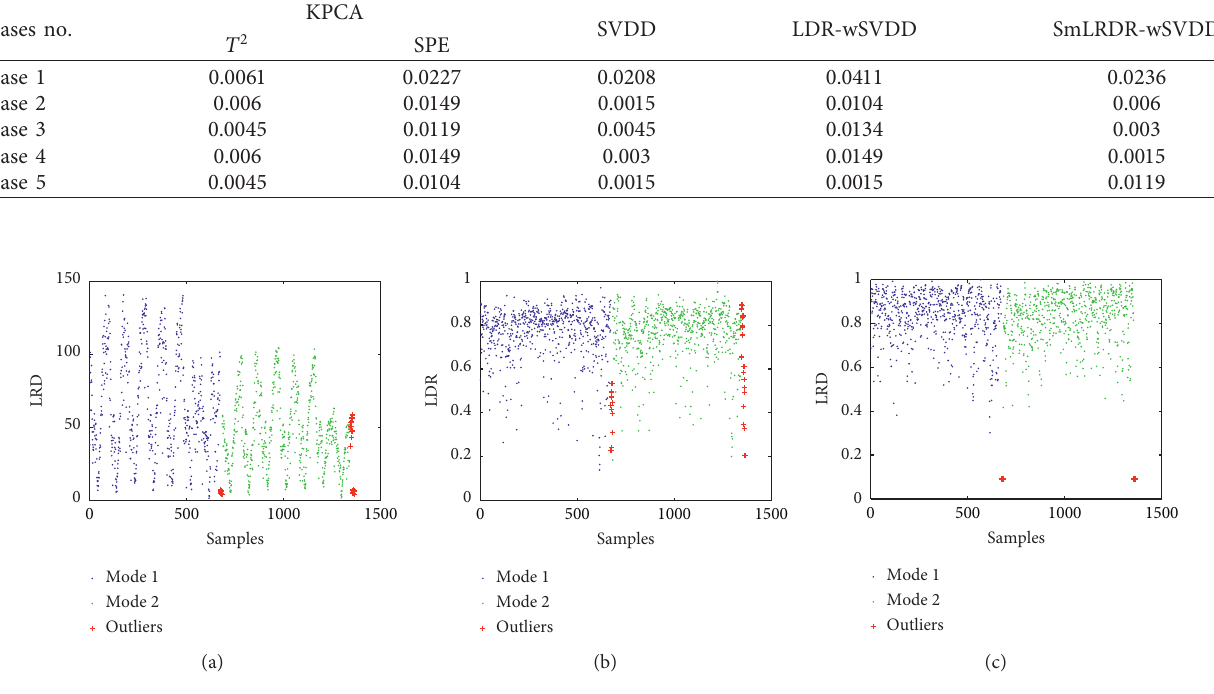
Figure 10: (a) LRD; the weight of each piece of training data based on (b) LDR and (c) mLRDR.